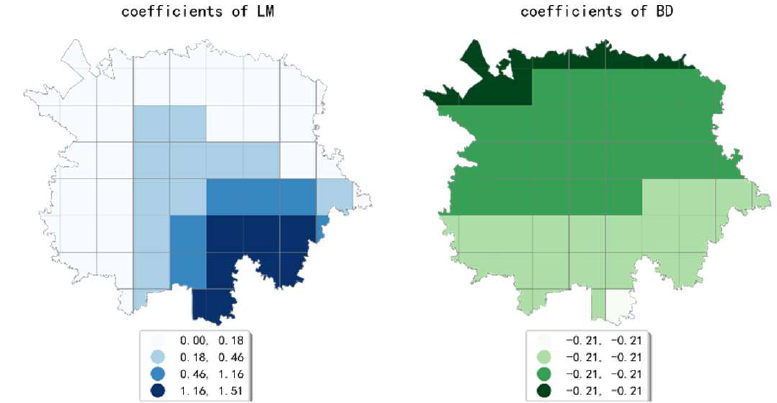
Figure 10. The estimated coefficients map in the grid with 4500 m.